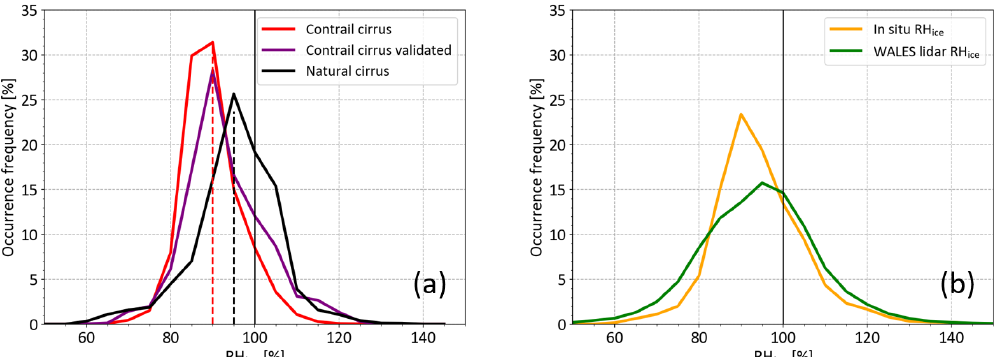
Figure 7. (a) Normalized RH ice occurrence frequency distributions in 5% RH ice bin width for the contrail cirrus identified using the combination of the Schmidt–Appleman criterion (SAC) and the cruising altitude range (CA) (red), contrail cirrus validated by the plume detection algorithm (purple), and natural cirrus not fulfilling SAC and located outside the CA range (black). The most frequently occurring RH ice in the contrail cirrus and natural cirrus is marked by the dashed red and black lines, respectively. (b) Normalized RH ice occurrence frequency distributions for all cirrus measured in situ (orange) and by the lidar WALES (green).